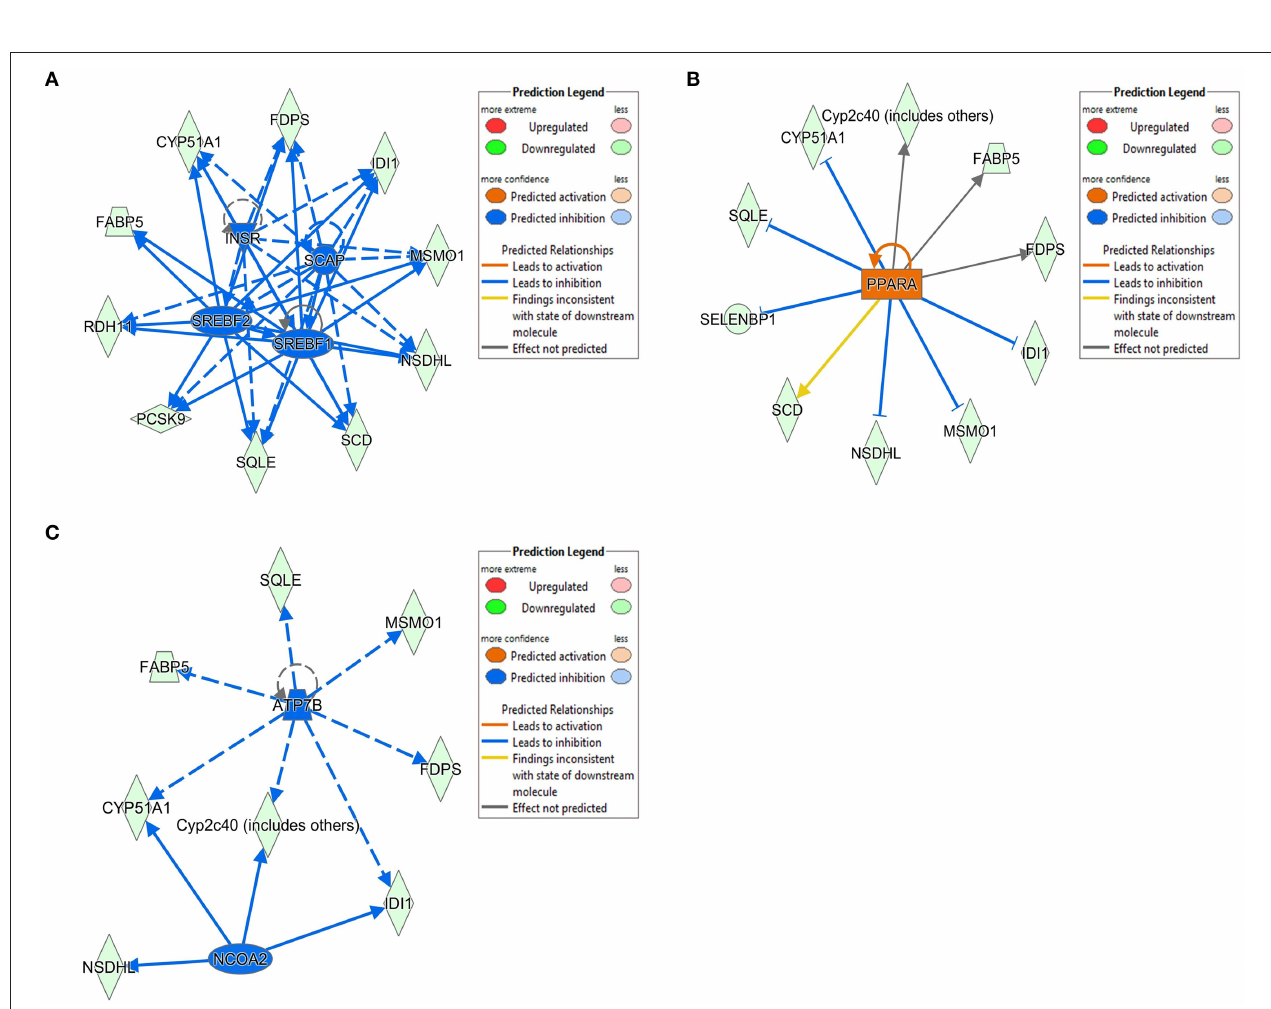
FIGURE 2 | DE genes between Phb1 + / − and WT, regulated by (A) Insr, Scap, Srebf1, and Srebf2; (B) Ppar α ; (C) Atp7b and Ncoa2. Red, green, orange, and blue represent upregulation, downregulation, predicted upregulation, and predicted downregulation, respectively.